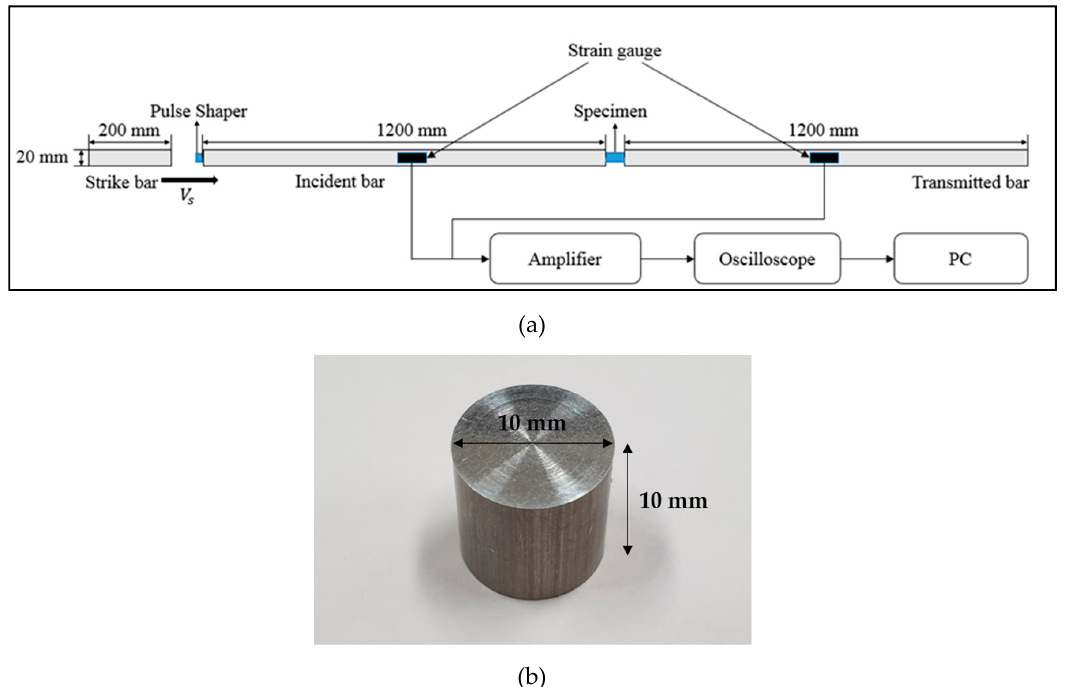
Figure 3. ( a )Conceptual design and ( b )specimen of the split Hopkinson Pressure Bar. Figure 3. ( a ) Conceptual design and ( b ) specimen of the split Hopkinson Pressure